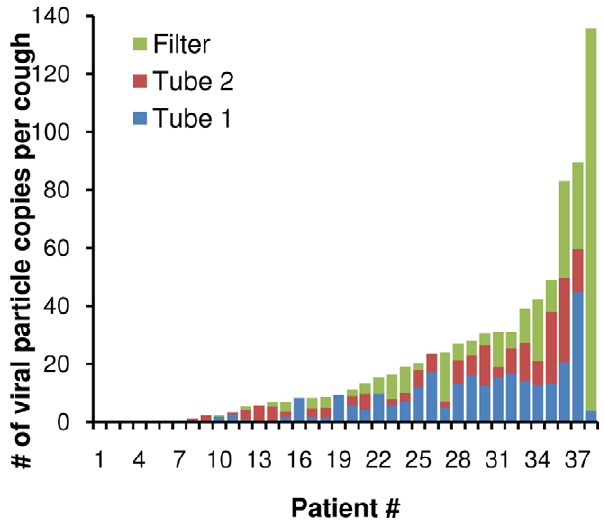
Figure 2. Influenza viral RNA collected from coughs using the NIOSH two-stage aerosol sampler. Influenza viral RNA was detected in the cough aerosols from 32 of 38 influenza-positive patients. This plot shows the number of viral copies per cough detected in aerosol particles collected in sampler tube 1 ( . 4 m m), tube 2 (1 to 4 m m) and the filter ( , 1 m m) for each patient, ordered from minimum to maximum. The particles collected in tube 2 and on the filter are respirable (able to reach the alveolar